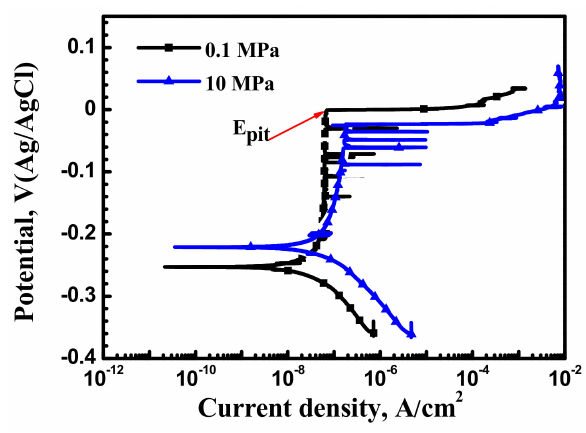
Figure 2. Polarization curves at 0.1 MPa and 10 MPa obtained with 0.2 mV/s scanning